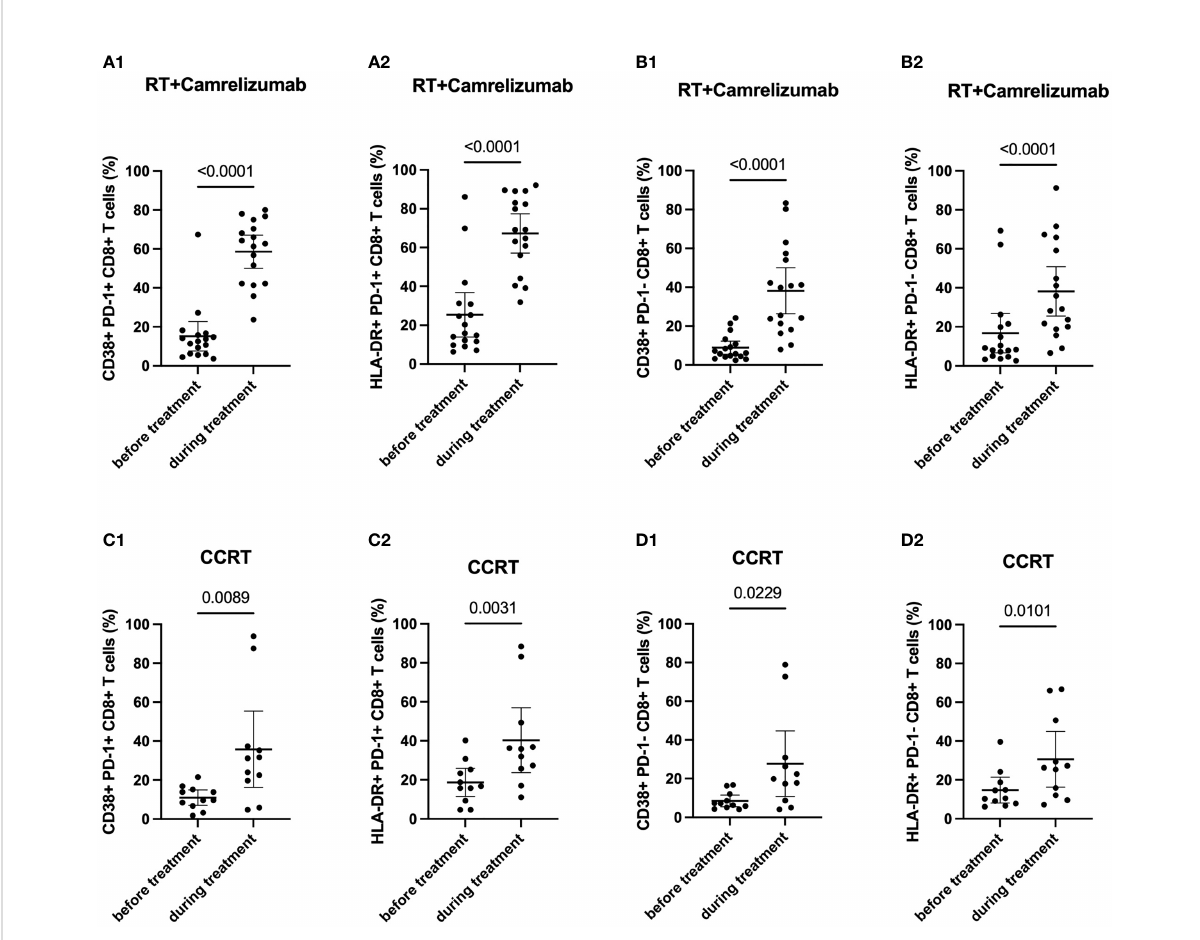
FIGURE 3 Dynamic characteristics in PD-1 + and PD-1 - CD8 + T-cell subsets. (A) PD-1 + CD8 + T cells in RT plus immunotherapy group. (B) PD-1 - CD8 + T